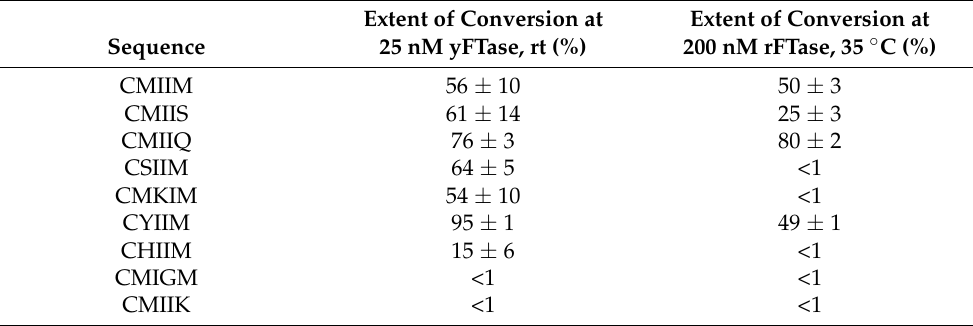
Table 2. Percent farnesylation of CaaaX peptides derived from MALDI libraries. Each value is the result of triplicate